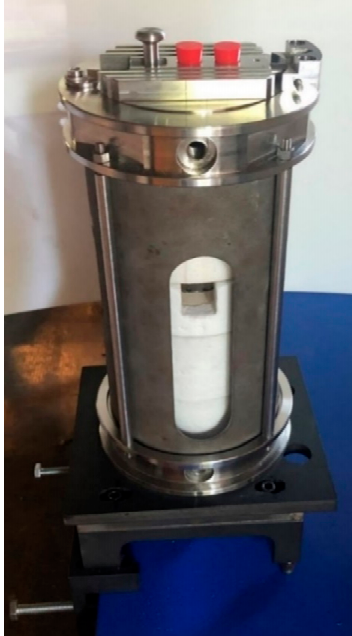
Figure 15. Picture of the furnace prototype after assembling.